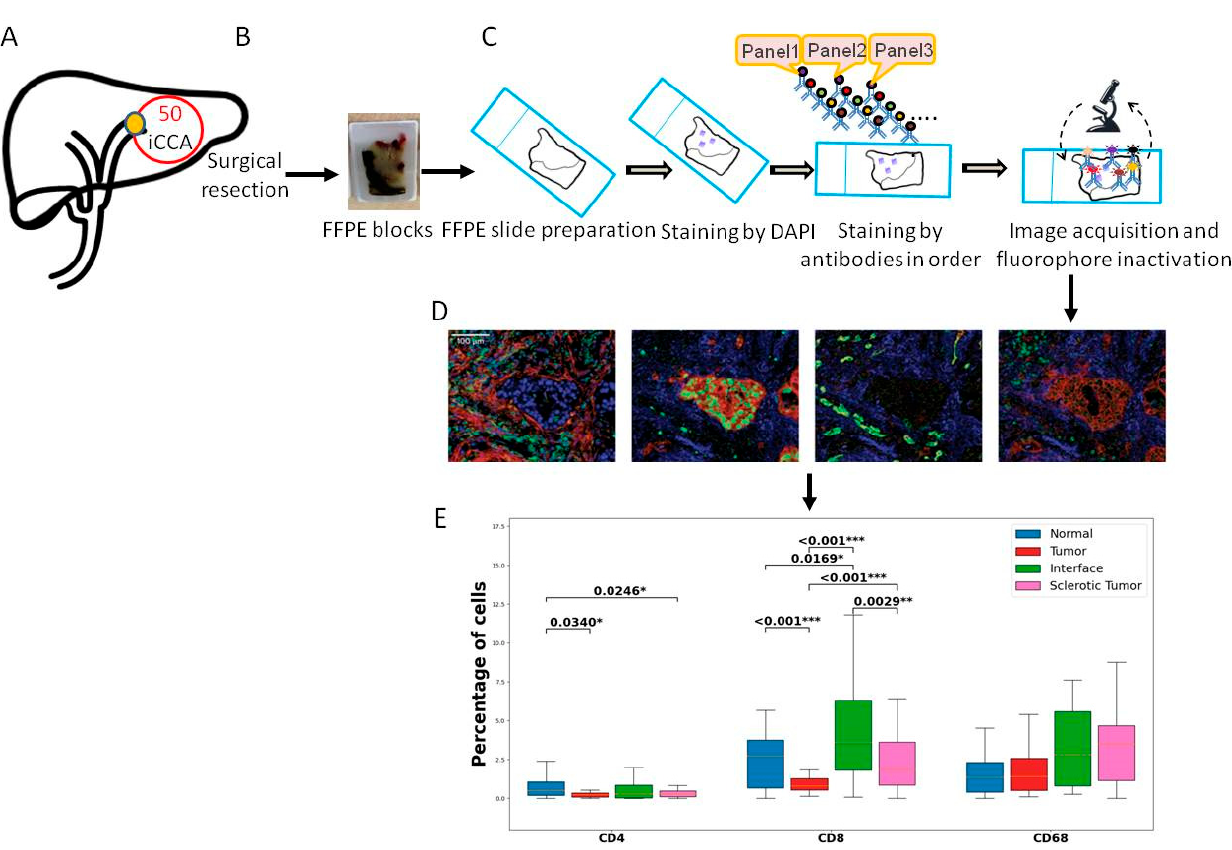
Figure 1. Overview of the study workflow. ( A ) Sample inclusion. We included 50 iCCA cancer samples. ( B ) All patients underwent surgical resection, and one representative FFPE block was collected from the pathology archive. ( C ) Slides were cut and prepared for the multiplex imaging workflow. First staining with DAPI was performed following the antibodies from all panels. Scanning was performed. ( D ) The slides were analyzed using tissuegnostics and software. ( E ) After quantification of the cells and measurement of co-expressions, statistical analysis was performed. Levels of significance: any P value less than 0.001 was designated with three (***) asterisks. p values between 0.001 and 0.01 are shown with two (**) asterisks and P values between 0.01 and 0.05 are shown with one (*) asterisk. iCCA: intrahepatic Cholangiocarcinoma, FFPE: Formalin-fixed paraffin-embedded, DAPI: 4 ′ ,6-diamidino-2-fenylindool nuclear staining.